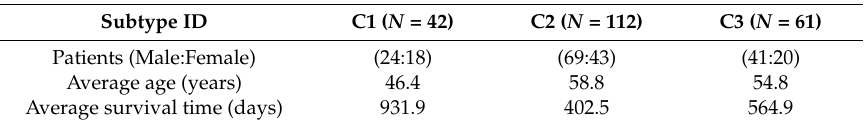
Table 6. The average initial diagnosis ages and survival times of patients in the identified subtype clusters in GBM cancer datasets.